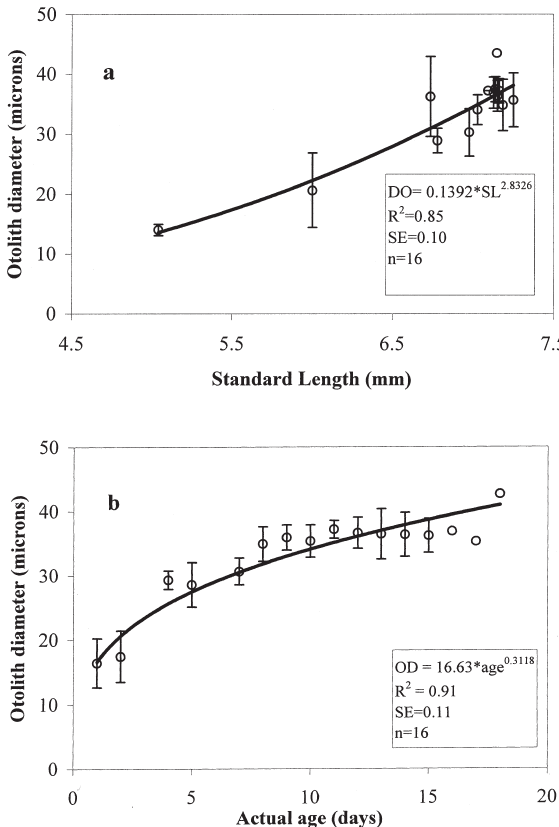
F IG . 3. – Relationships of otolith diameter (OD) with (a) standard length (Sl) and (b) actual age. Bars represent standard error.